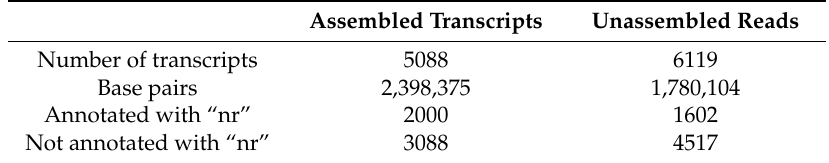
Table 3. Bioinformatics analysis results for the head kidney transcriptome of Eleginops maclovinus